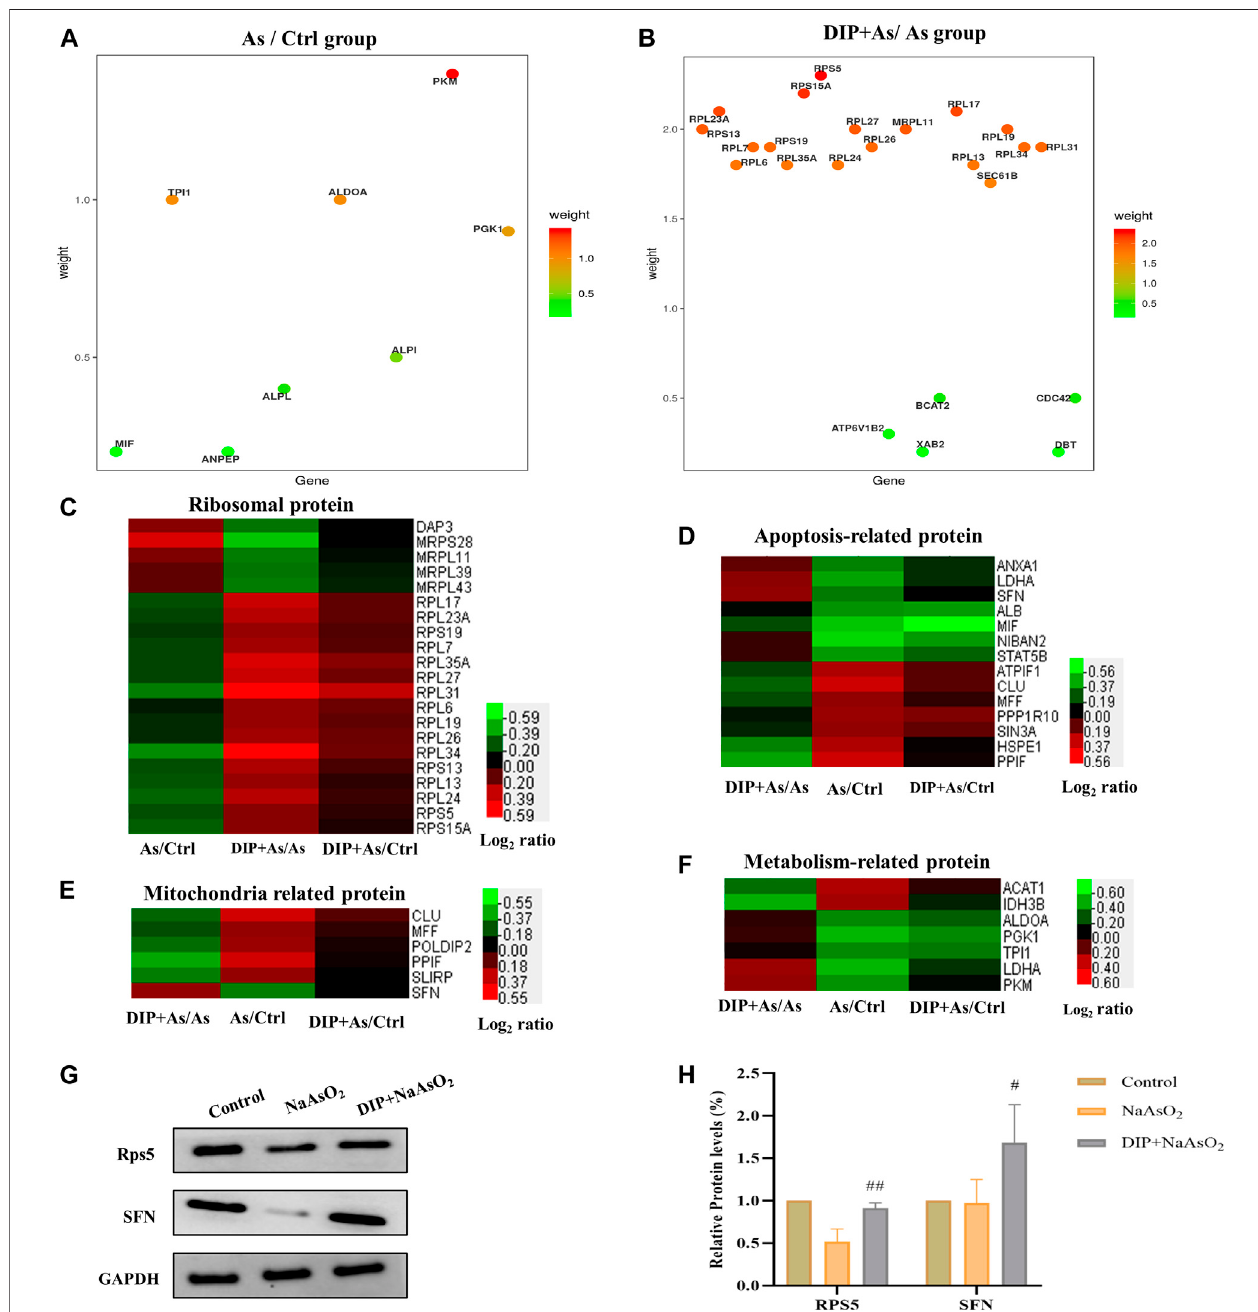
FIGURE 5 | Hub gene and cluster analysis and Western blot analysis veri fi cation of DEPs in the key pathways. (A) The bubble chart the differentially expressed proteins associated with As/Ctrl group. (B) The bubble chart the differentially expressed proteins associated with DIP + As/As group. (C) Cluster analysis of ribosomal proteinsindifferentgroups. (D) Clusteranalysisofapoptosis-related proteins indifferentgroups. (E) Clusteranalysisofmitochondriarelated proteinsindifferentgroups. (F) Cluster analysis of metabolism-related protein in different groups. (G,H) The differential expression proteins were veri fi ed by Western blot analysis.